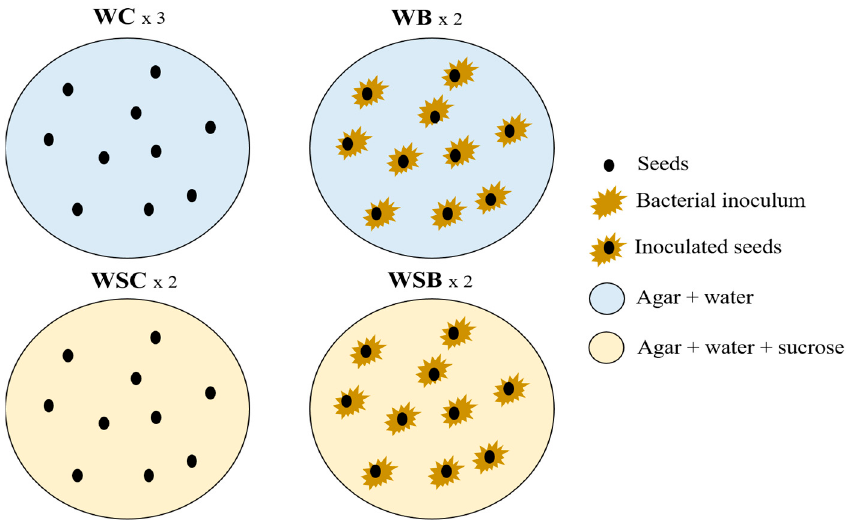
Figure 1. Schematic representation of the four treatments used for seed germination test.